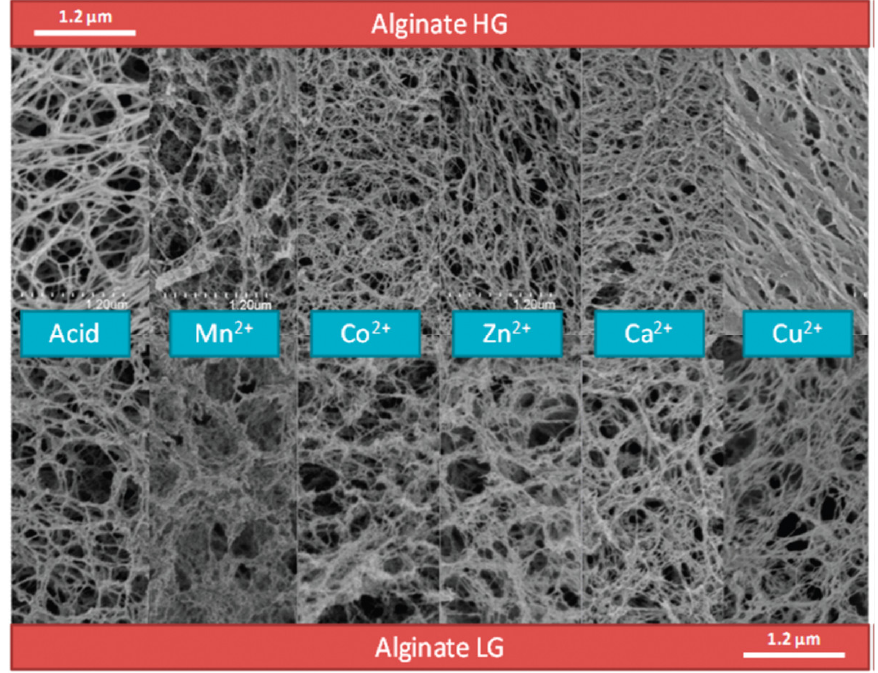
Figure 8. SEM micrographs of HG and LG metal-alginates aerogels. Reprinted with permission from [233] (Copyright 2012, American Chemical